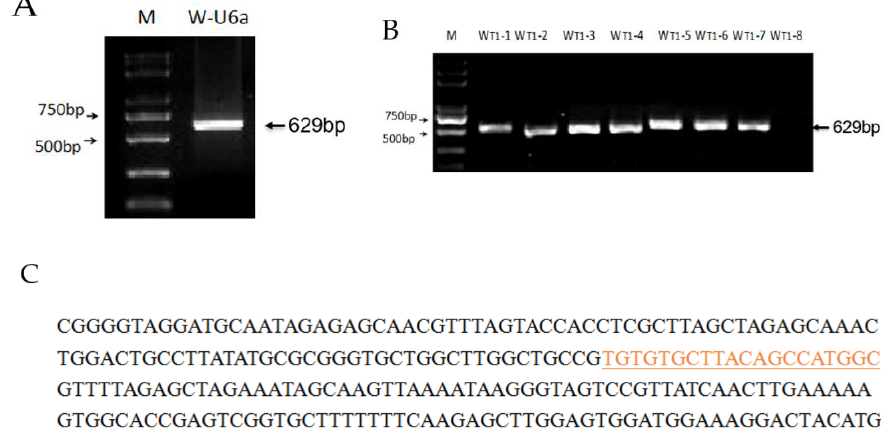
Figure 2. Construction of vector and verification of sgRNA. ( A ) Detection results of sgRNA expression cassette; ( B ) veri- fication of the size of Wx gene cas9/sgRNA expression vector segment; ( C ) verification of Wx gene cas9/sgRNA expres- sion vector sequencing. M: marker; WT1-1 — WT1-8: W X gene cas9/sgRNA expression vector; 750 bp, 500 bp, 629 bp: fragment size; red part: target sequence.